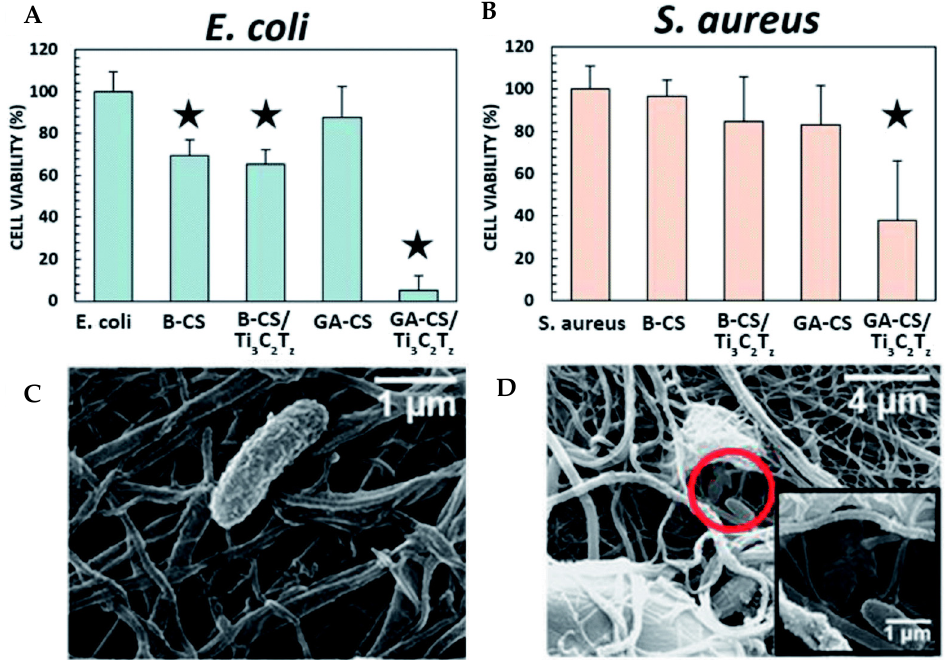
Figure 4. ( A ) E. coli and ( B ) S. aureus antibacterial activity B-X and GA-X are mats that have been treated with NaOH and glutaraldehyde, respectively. On the 0.75 wt.% Ti 3 C 2 Tz/CS nanofiber mat, SEM micrographs reveal ( C ) undamaged and ( D ) destroyed E. coli bacteria. The star symbol denotes samples that differ substantially from the control, p ≤ 0.05 [63].